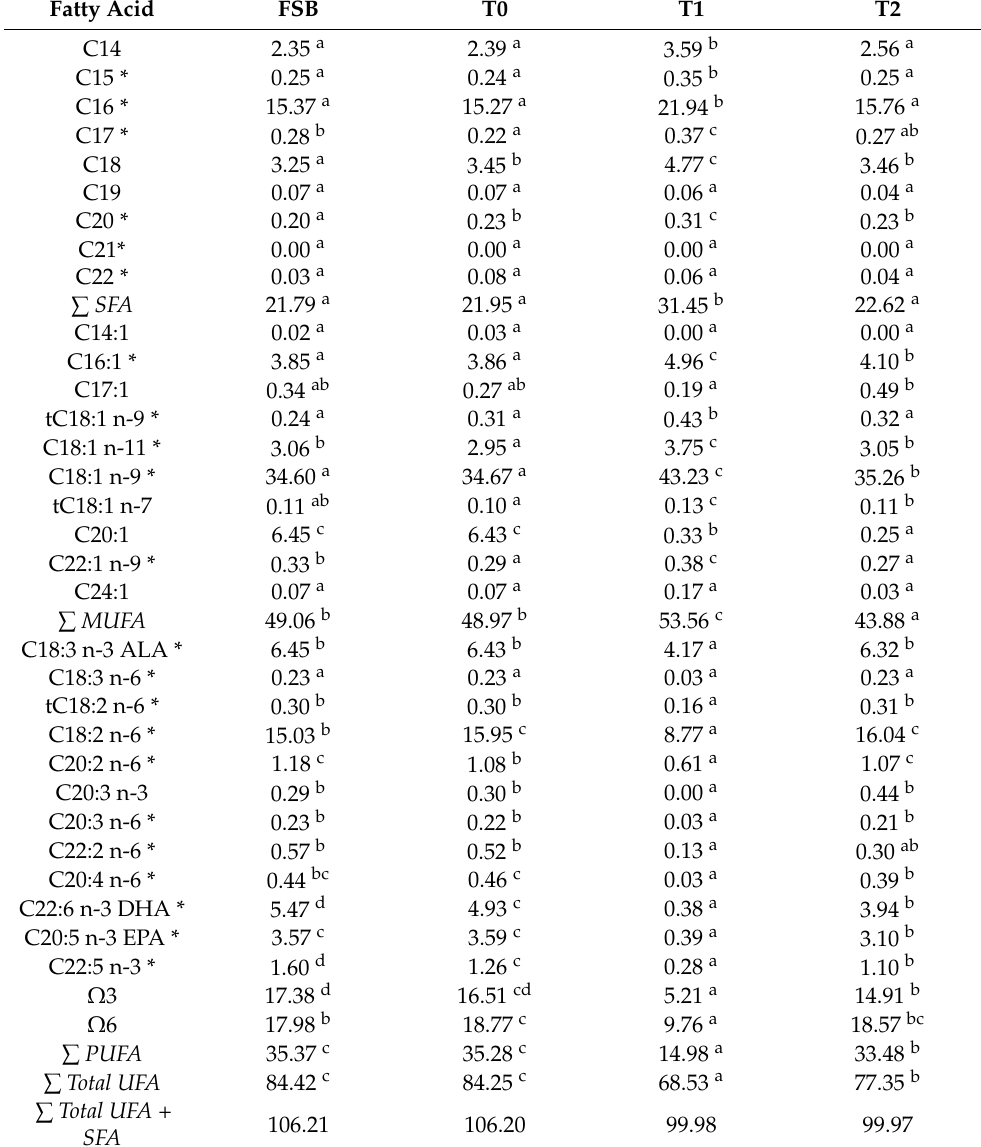
Table 3. Fatty acid composition of fresh seabass (FSB), MDDM at day 0 (T0), MDDM at the end of the experiment at 65 ◦ C (T1), and MDDM with 0.2% Nutrabiol ® at the end of the experiment at 65 ◦ C (T2). The end of the experiment was at day 50. Different letters in the same row indicate statistically significant differences between samples (* p <